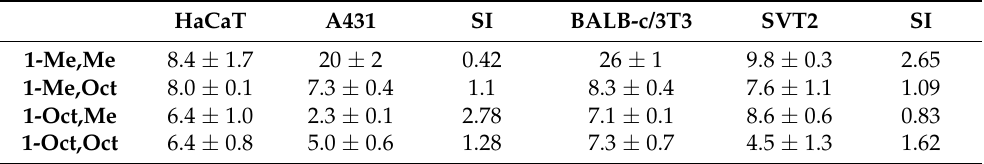
Table 2. IC 50 values ( µ M) obtained for Pt complexes on HaCaT, A431, BALB/c-3T3 and SVT2 cells after 48 h incubation. The selectivity indexes (SI) are indicated by the ratios between the IC 50 values of the immortalized cells and cancer cells.